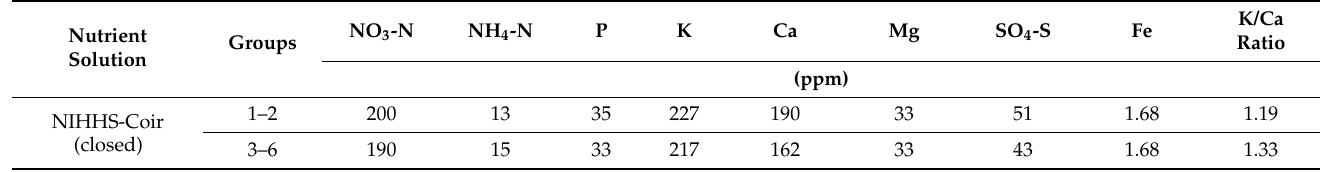
Table 5. Newly developed nutrient solution compositions for paprika cultivation in the closed hydroponic system with a coir substrate in the winter cropping